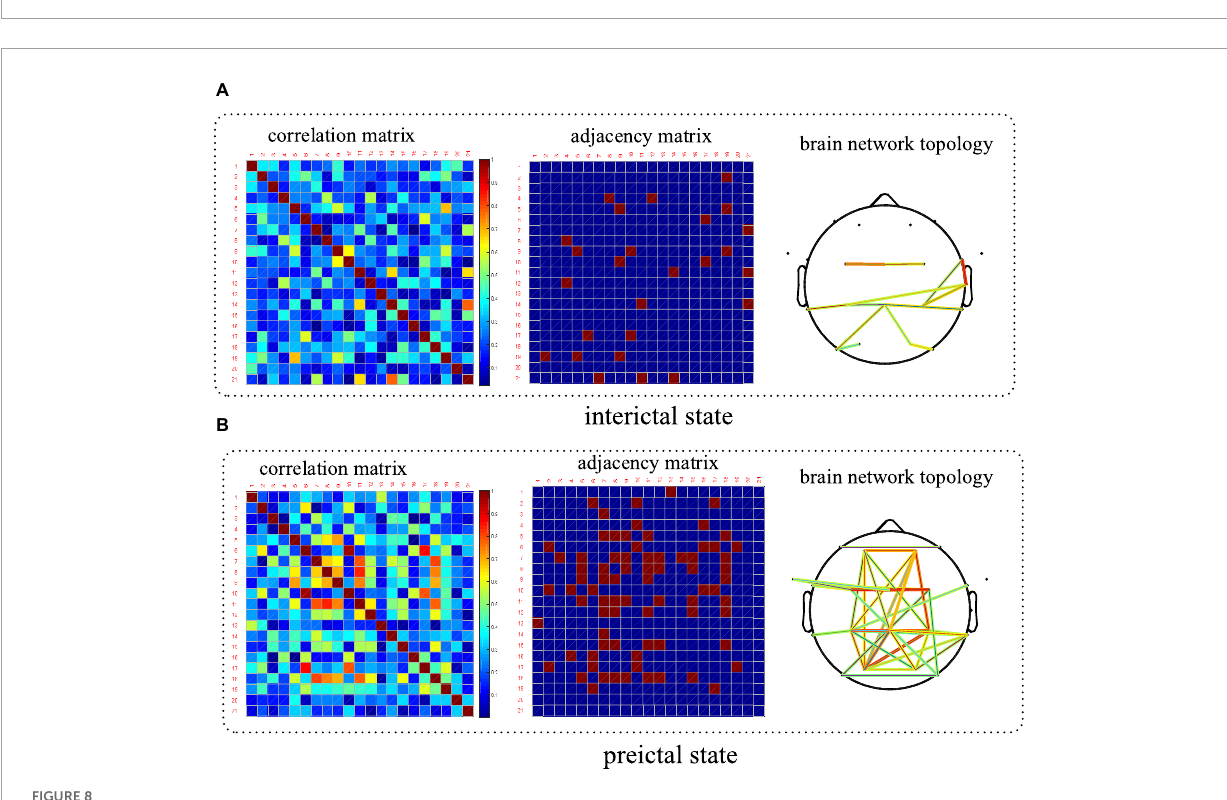
FIGURE8 Comparison of the spatial features based on brain network between the interictal and preictal states. Patient number chb06 has been taking as an example. (A) Brain network in the interictal state and (B) is in the preictal state.